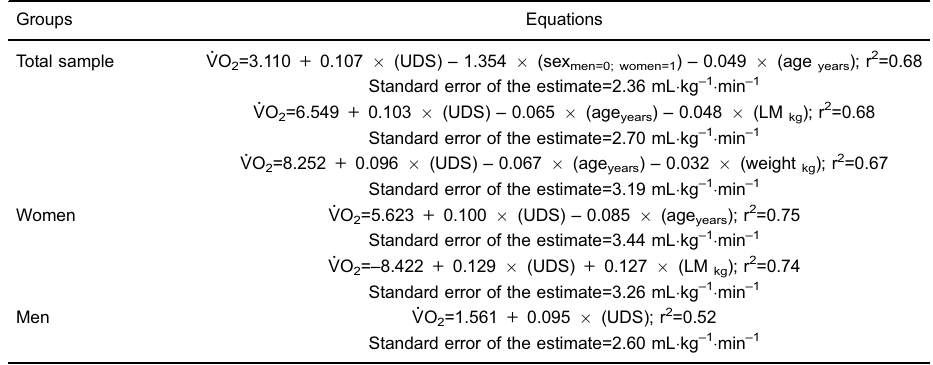
Table 3. Reference equations of oxygen uptake in the six-minute step test for obese people. Groups